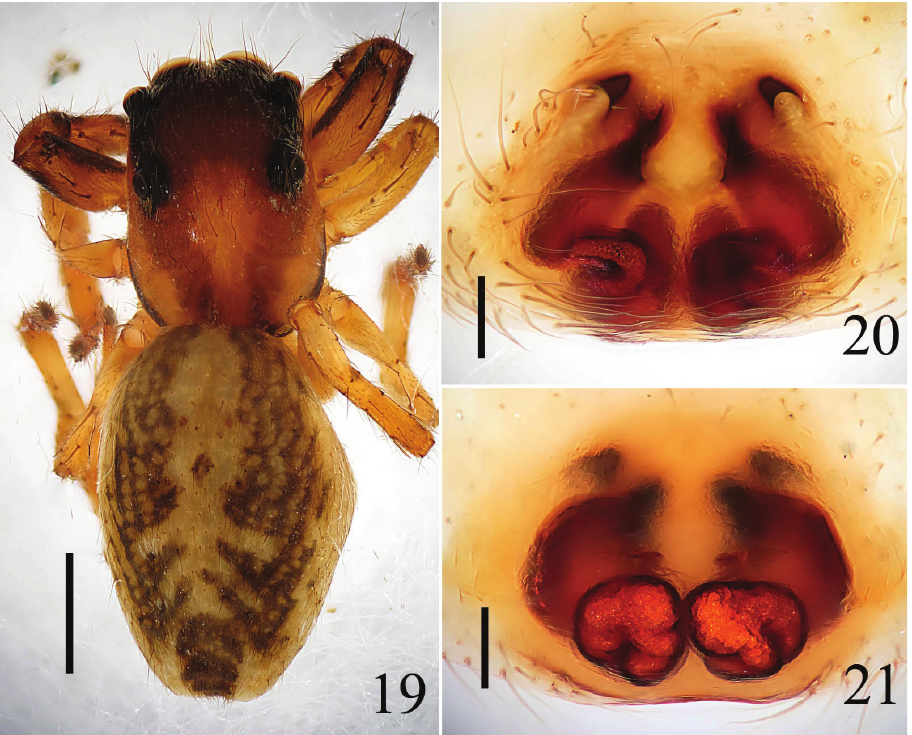
Figures 19–21. Yaginumaella pseudoflexa sp. n. 19 female body, dorsal view 20 epigynum, ventral view 21 vulva, dorsal view. Scale bars: 0.1 mm.